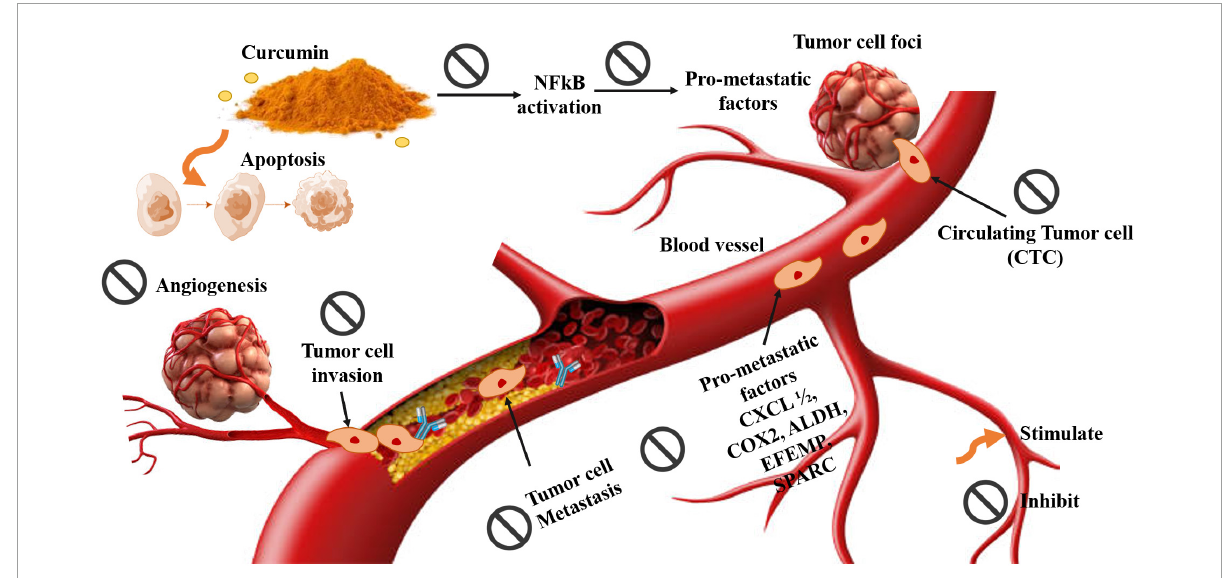
FIGURE8 Anticancer mechanism of bioavailable curcumin against numerous types of